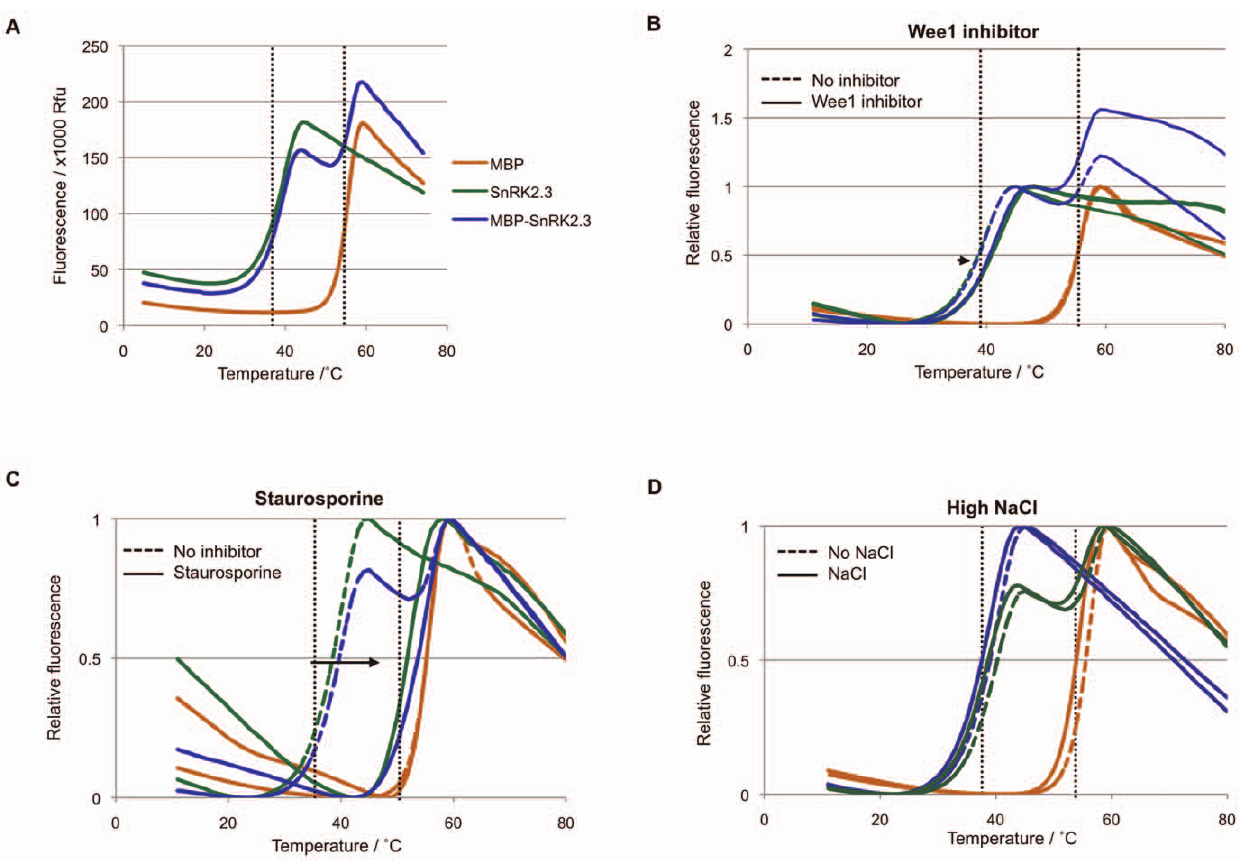
Figure 9. SnRK2 kinase inhibitors affect the thermostability of the SnRK2.3 moiety, but not the MBP moiety, of a MBP-SnRK2.3 fusion protein. ( A ) Melting profiles of SnRK2.3 (green), MBP (brown), and a MBP-SnR2.3 fusion protein (blue). The fusion protein underwent two separate unfolding transitions: the transition at lower temperature corresponds to that of the kinase while the unfolding at the higher temperature corresponds to that of the more stable MBP tag. ( B–D ) Melt curves of SnRK2.3, MBP, and the MBP-SnRK2.3 fusion protein in the presence of Wee1 inhibitor ( B ), staurosporine ( C ), and 500 mM NaCl ( D ). The color code is the same as in (A), with dashed lines representing the melt curves in the absence of inhibitors and solid lines those with inhibitors. Dotted black lines indicate the Tm of SnRK2.3 and MBP in the absence of